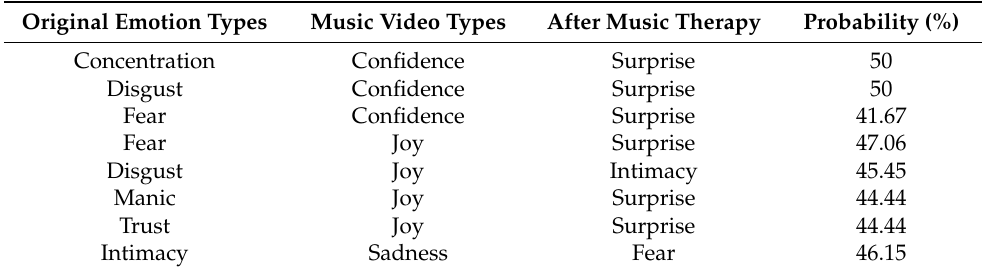
Figure 10. Emotion parallel graph. ( a ) 20 emotions; ( b ) parallel graphs of joy, surprise, and intimacy. Table 7. Music video types and emotion